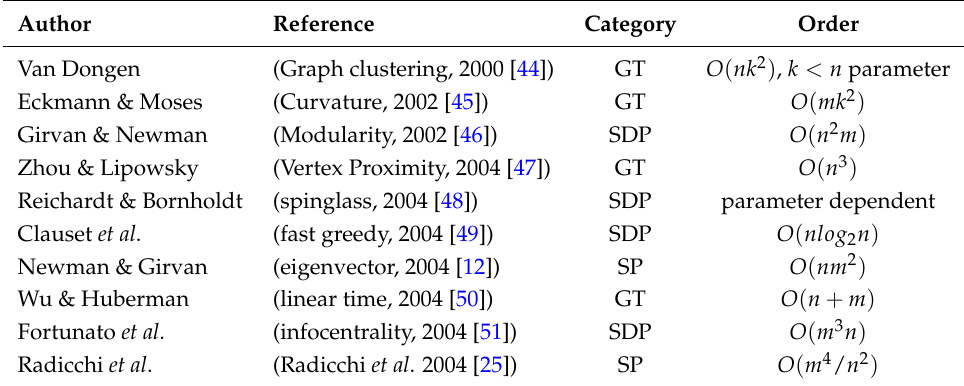
Table 1. Algorithms for network community detection and their